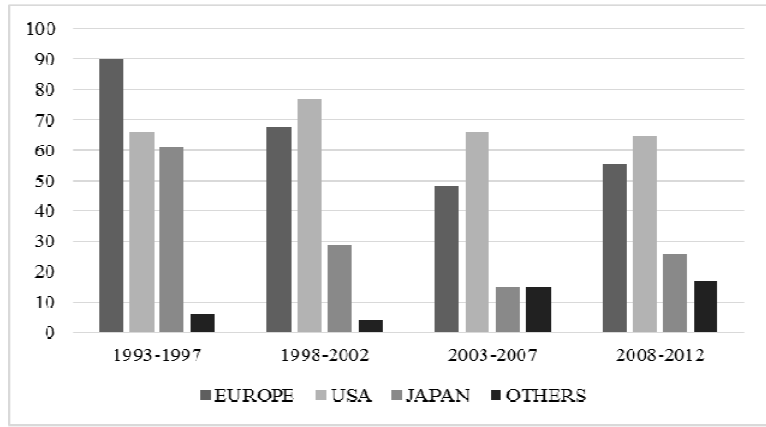
Figure 3: Number of New Chemical or Biological Entities by Area (1993-2012)